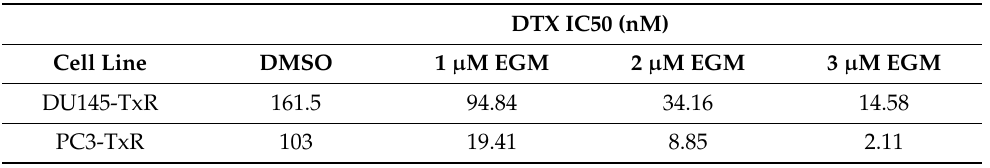
Table 1. Docetaxel IC50 to chemo-resistant prostate cancer cells is decreased along with elevation of Eggmanone in a dose dependent